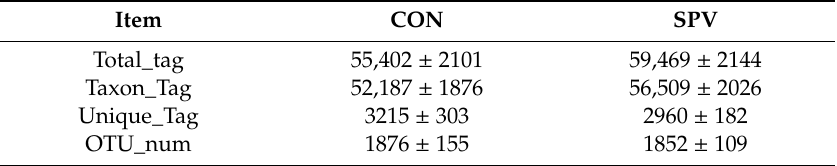
Table 5. Tags and Operational Taxonomic Units (OTUs) between the treatments.